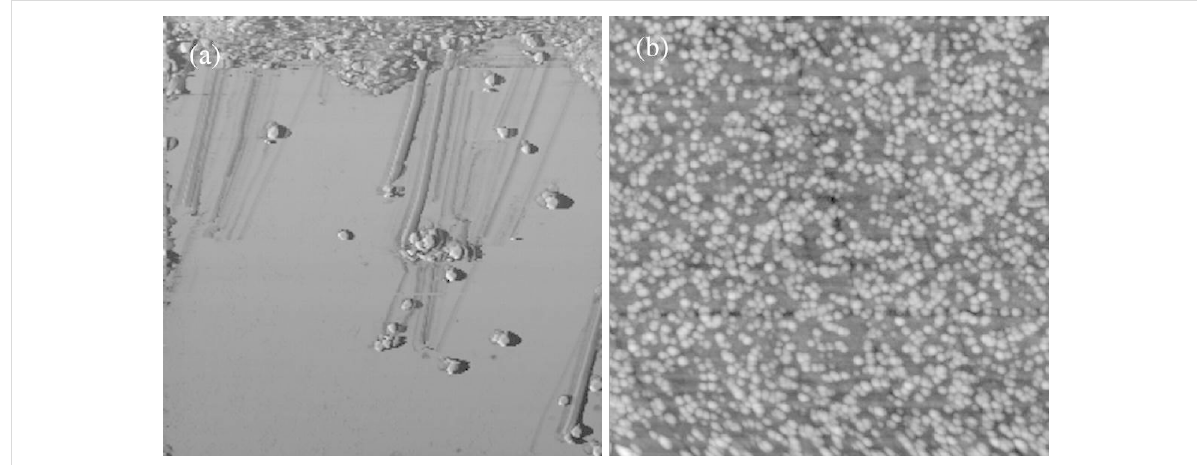
Figure 3: (a) Phase image of nanoparticles (B) adsorbed and manipulated on mica substrate. (b) Topography image of nanoparticles (A) adsorbed on enamel substrate. Scan size is for both images 10 μ m.